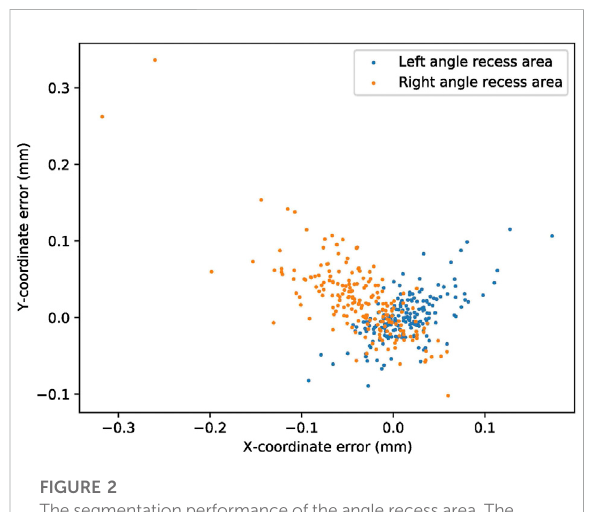
FIGURE 2 The segmentation performance of the angle recess area. The blue and orange dots represent the X-coordinate and Y-coordinate errors of the angle recess area,